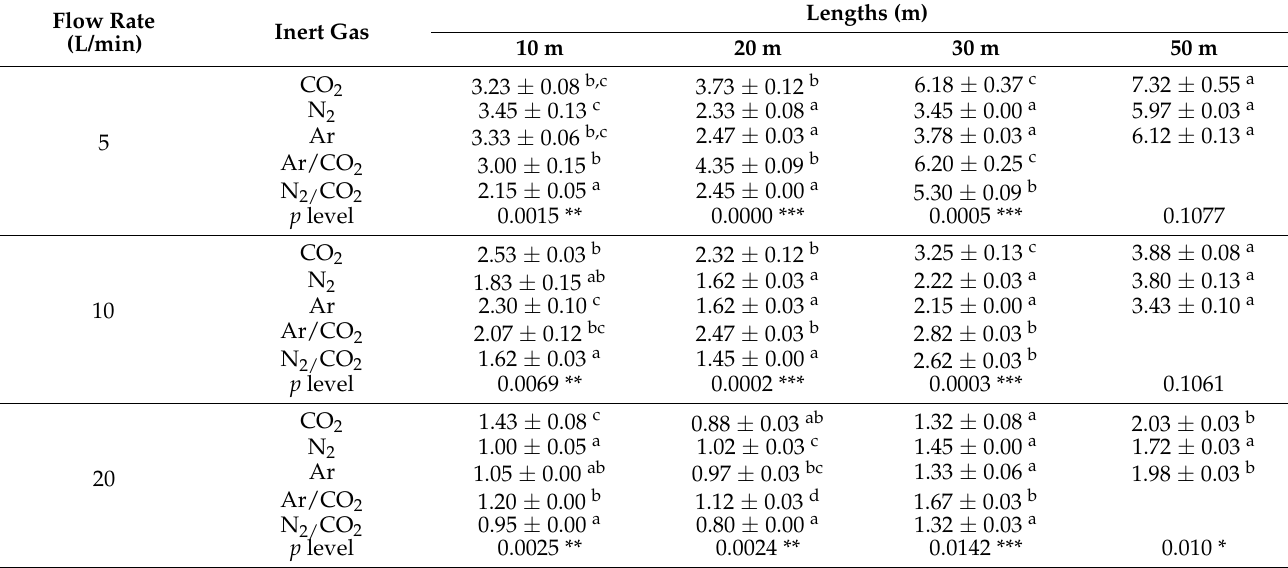
Table 5. Time required (min) to lower the oxygen partial pressure in a DN32 butyl rubber hose of different lengths with the different inert gases tested ( n = 3).